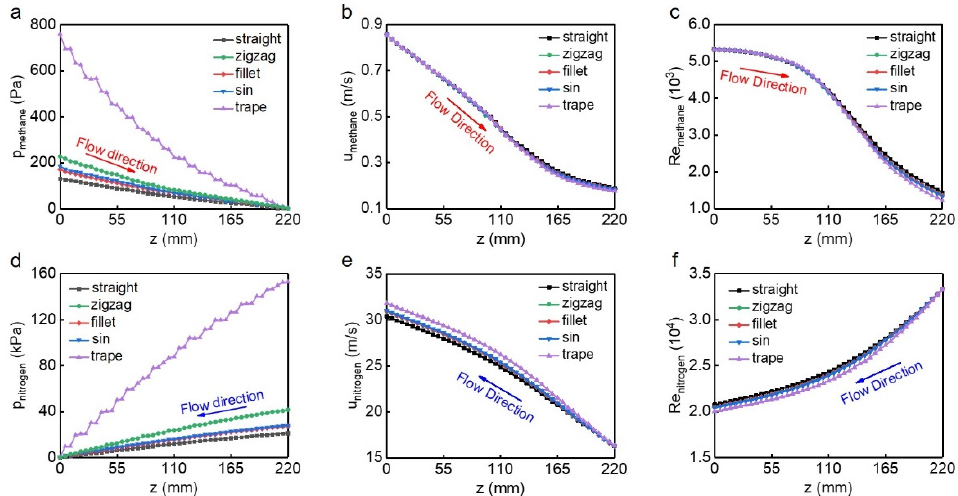
Figure 8. Pressure, velocity and Reynolds number of the hot ( a – c ) and cold ( d – f ) fluids, respectively. The outlet pressure is set at 0 MPa in ( a , d ).